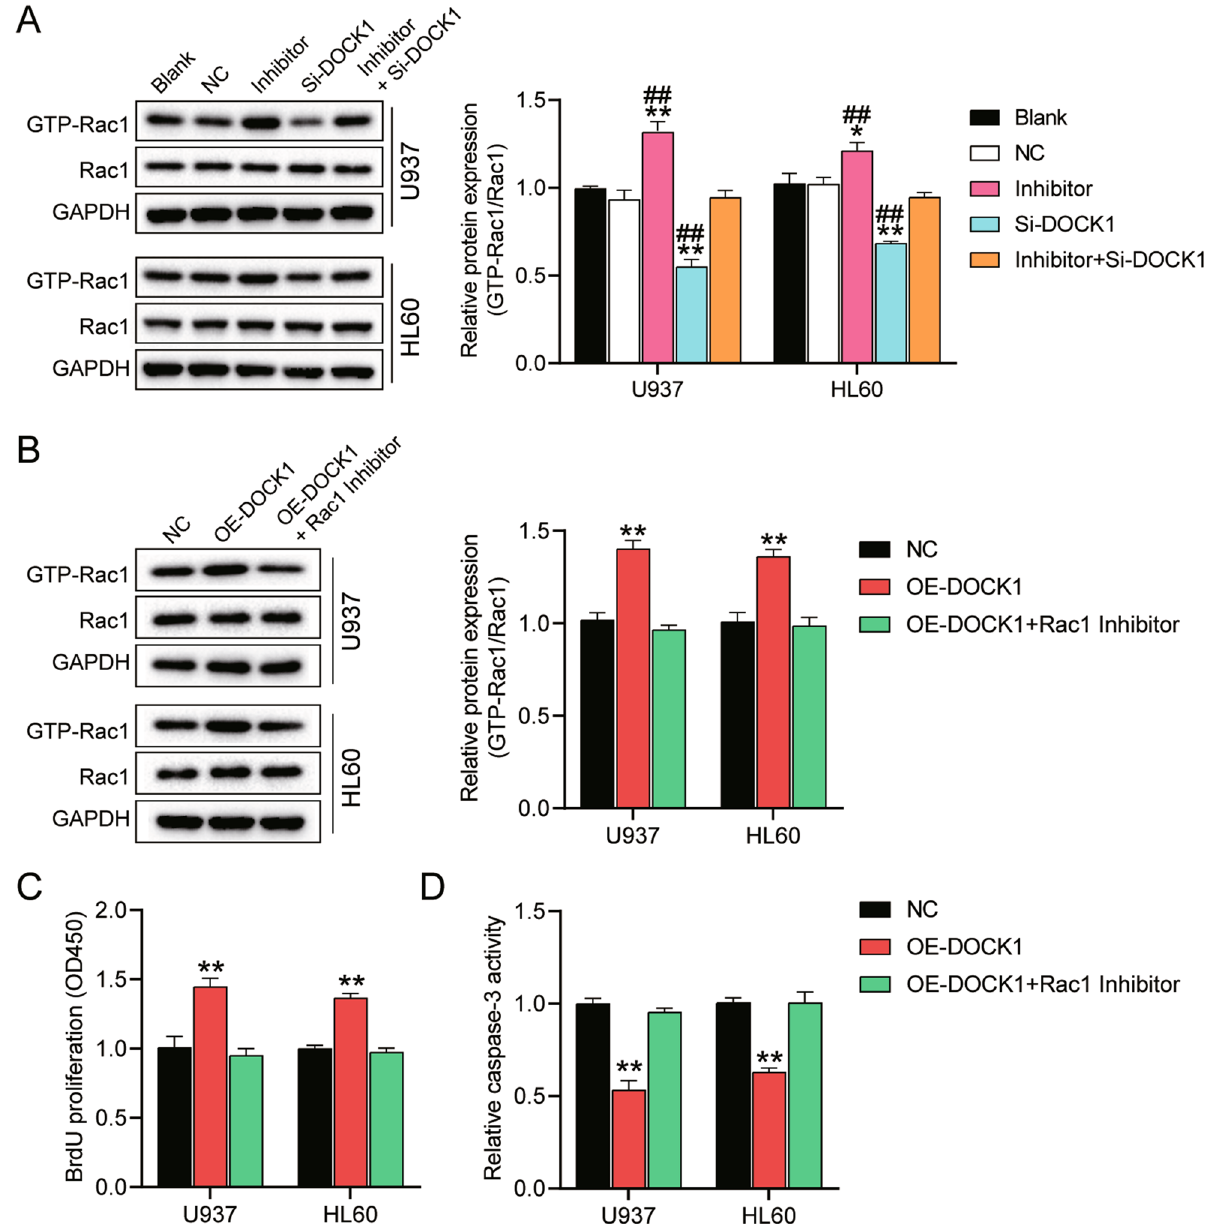
Figure 6. DOCK1 aggravates the AML progression through the activation of Rac1. ( A ) Western blot analysis of the relative expression of GTP-Rac1 complex in U937 and HL60 cells transfected with DOCK1 siRNA (si-DOCK1), miR-4458 inhibitor (inhibitor), DOCK1 siRNA and miR-4458 inhibitor (inhibitor + si-DOCK1), negative control (NC) or cells with no treatment (Blank). GAPDH served as the reference control. * P < 0.05; ** P < 0.001 versus Blank group; # P < 0.05; ## P < 0.001 versus inhibitor + si-DOCK1 group. ( B ) Western blot analysis of the relative expression of GTP-Rac1 complex in U937 and HL60 cells transfected with negative control (NC), DOCK1 overexpression vectors (OE-DOCK1) and/or treated with 50 μM Rac1 inhibitor. GAPDH served as the reference control. ** P < 0.001 versus NC group. ( C ) BrdU assay was performed to determine the proliferative capacity of U937 and HL60 cells in the above three groups. ** P < 0.001 versus NC group. ( D ) Caspase-3 activity was evaluated to reflect the apoptosis of U937 and HL60 cells in the above three groups. ** P < 0.001 versus NC group. Three biological repeats were performed for each experiment, and the data were shown as mean ± SD. Statistics analysis was carried out with Student’s t -test or one-way